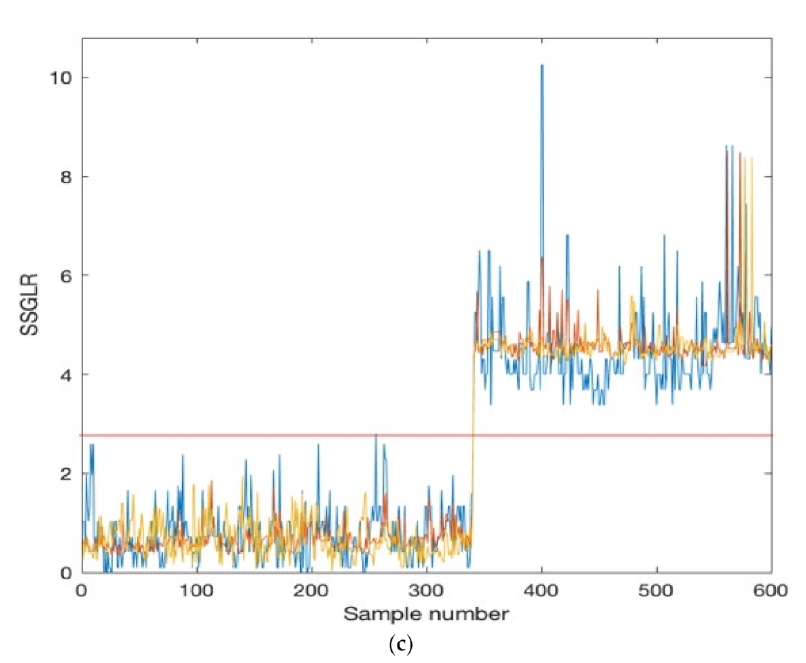
Figure 8. ( a ) KPCA-KDE based T 2 chart fault detection results in quality non-pertinent; ( b ) KPCA- KDE-based Q chart fault detection result in quality non-pertinent; ( c ) KPCA-KDE-based SSGLR chart fault detection result in quality